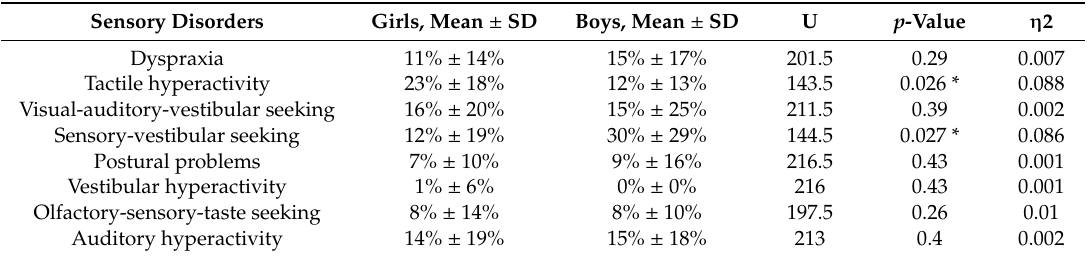
Table 6. Di ff erences between girls and boys in the results of the sensory